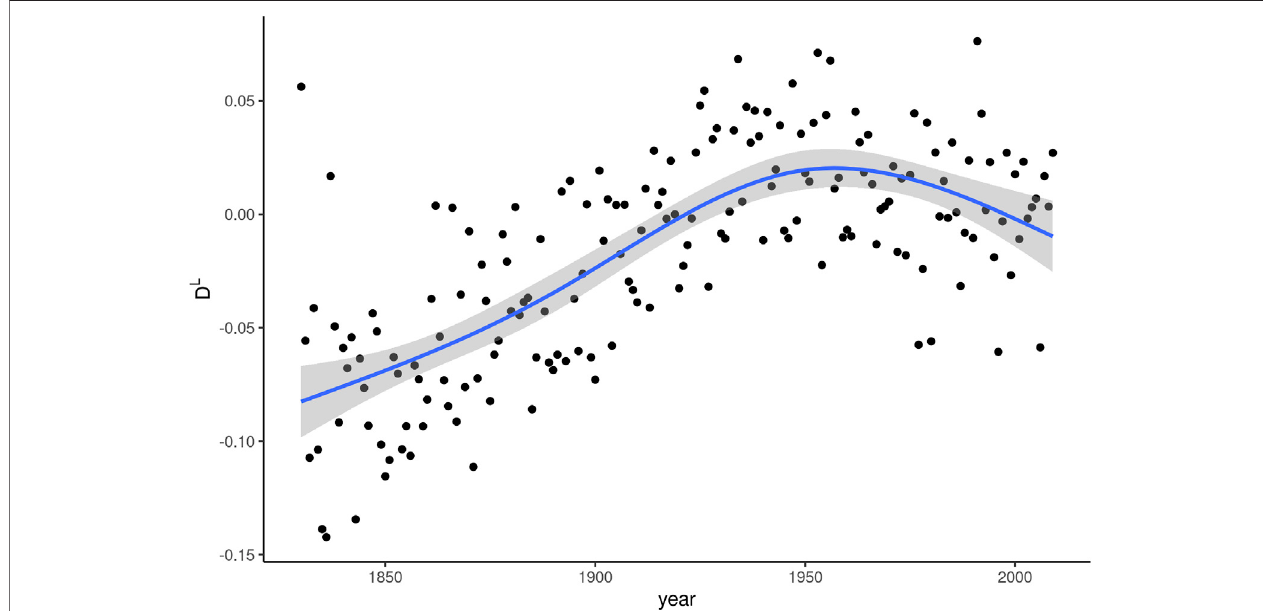
FIGURE 3 | Linguistic dissemination (D L ) of whom over 180 years of written American English.